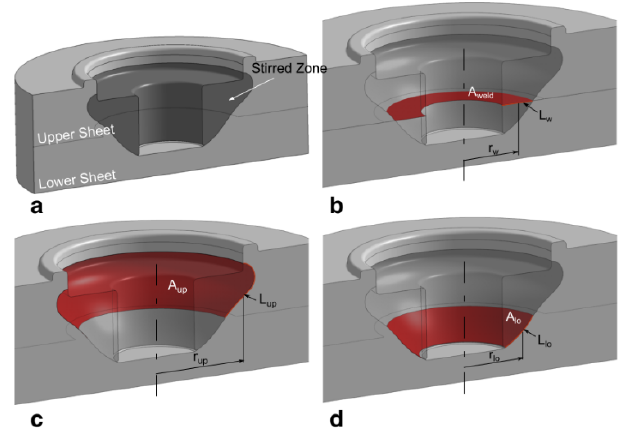
Figure 25. Effect of plunging depth on geometry of the weld [77].